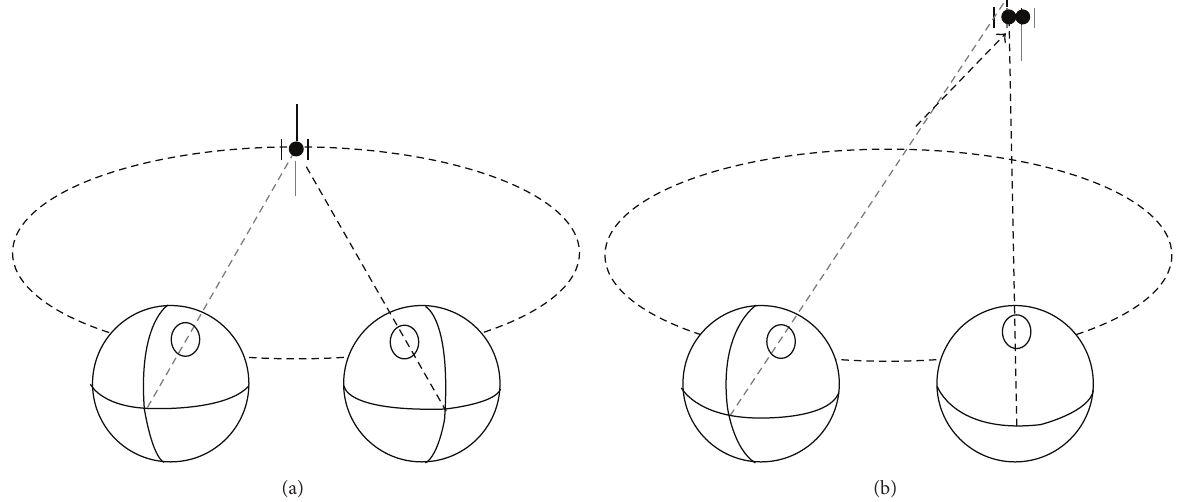
Figure 7: Illustration of the observers’ task in Experiment 2. A typical ascending trial: after free-fusing the stimulus, observers moved it out along one of twelve radii until the Nonius lines were perceived as misaligned. Initial eye posture is shown in (a). Perception as the eyes reach the limit of the bifixation field is shown in (b). The black Nonius line was visible to the right eye; the grey Nonius line was visible to the left eye. Dashed circle represents an isovergence circle for